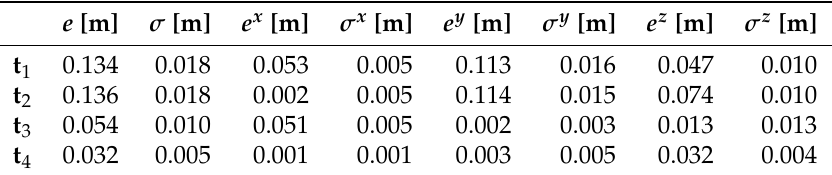
Table 4. Experimental results in Configuration 4: measured average errors ( e , e x , e y , and e z ) are shown together with the relative standard deviations ( σ , σ x , σ y , and σ z ) for the four considered positions ( t 1 , t 2 , t 3 , and t 4 ) of the